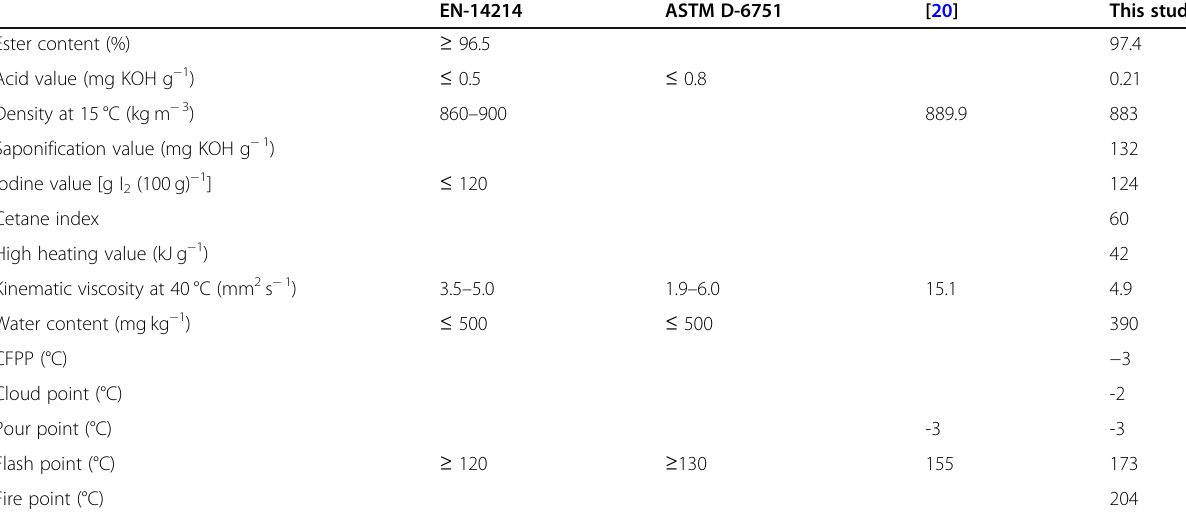
Table 3 Characteristics of CMOME produced at optimum conditions in comparison with